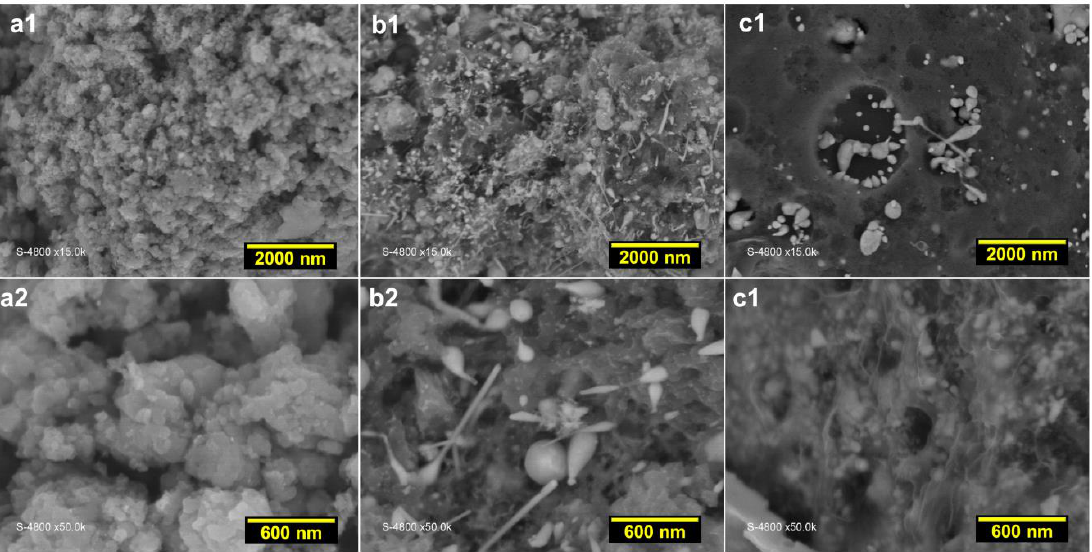
Figure 5. SEM characterization of the materials obtained after polymerization (5 °C, 13 h), stabilization (air, 350 °C, 2 h) and calcination (N 2 , 900 °C, 6 h): backscattered SEM images at different magnification for: ( a1 , a2 ) PANI-TS-TC, ( b1 , b2 ) PANI-Ni-TS-TC, and ( c1 , c2 ) PANI-Co-TS-TC.